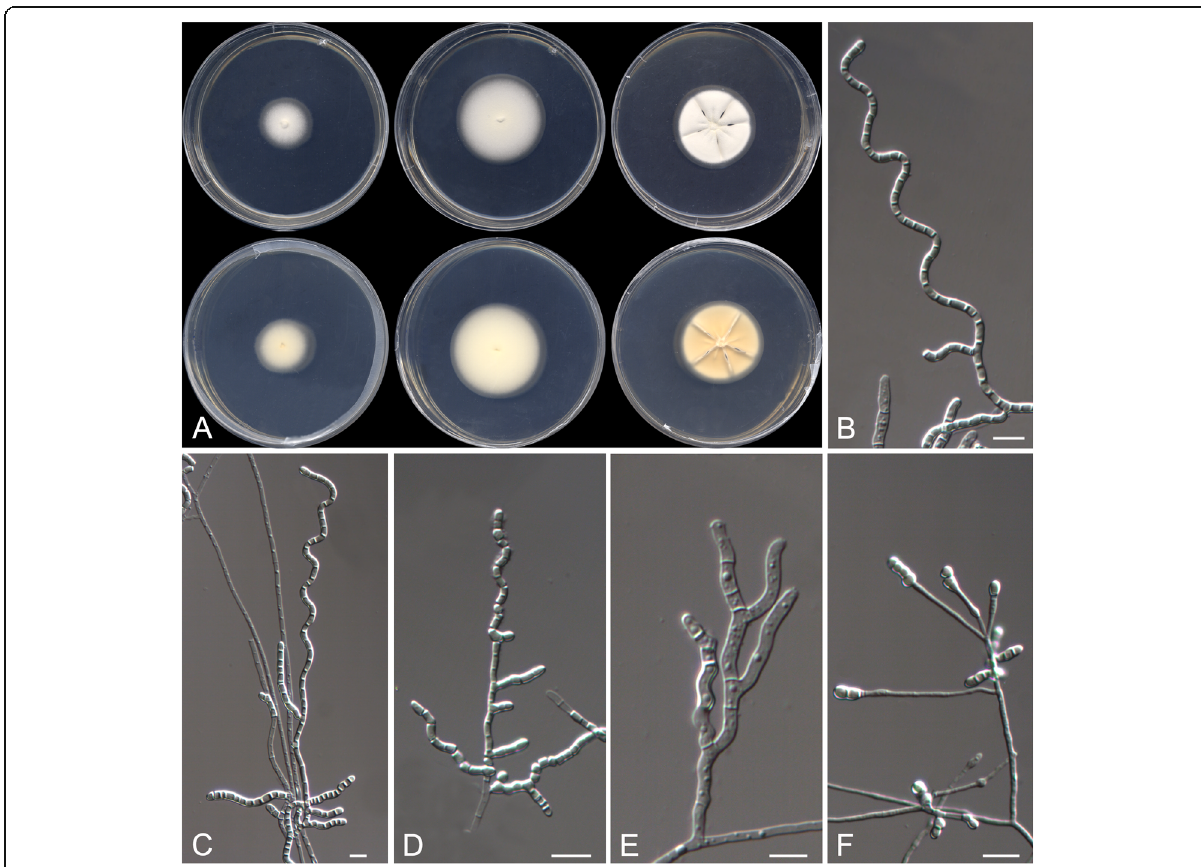
Fig. 5 Helicoarthrosporum mellicola CBS 143838 T . a Colonies on G18 at 15 °C and at 25 °C, and on PDA at 25 °C (from left to right), surface and reverse (from top to bottom). b – e Conidiophores. d Chlamydospores on OA. Scale bar = 10 μ